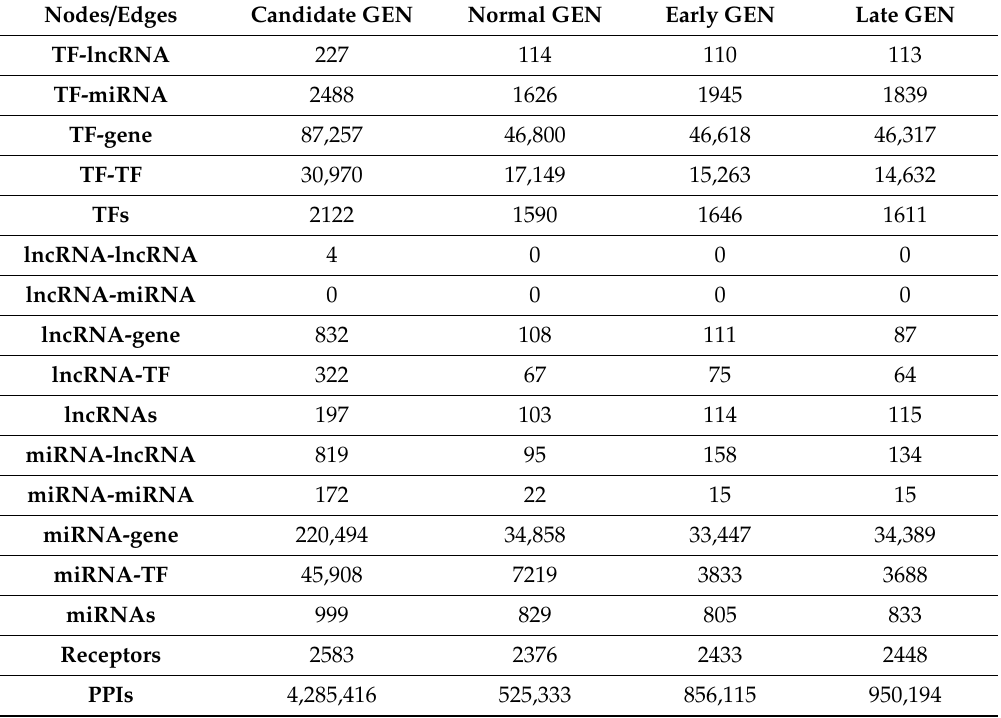
Table 1. The total number of nodes and edges in candidate GENs and identified GENs at each stage of